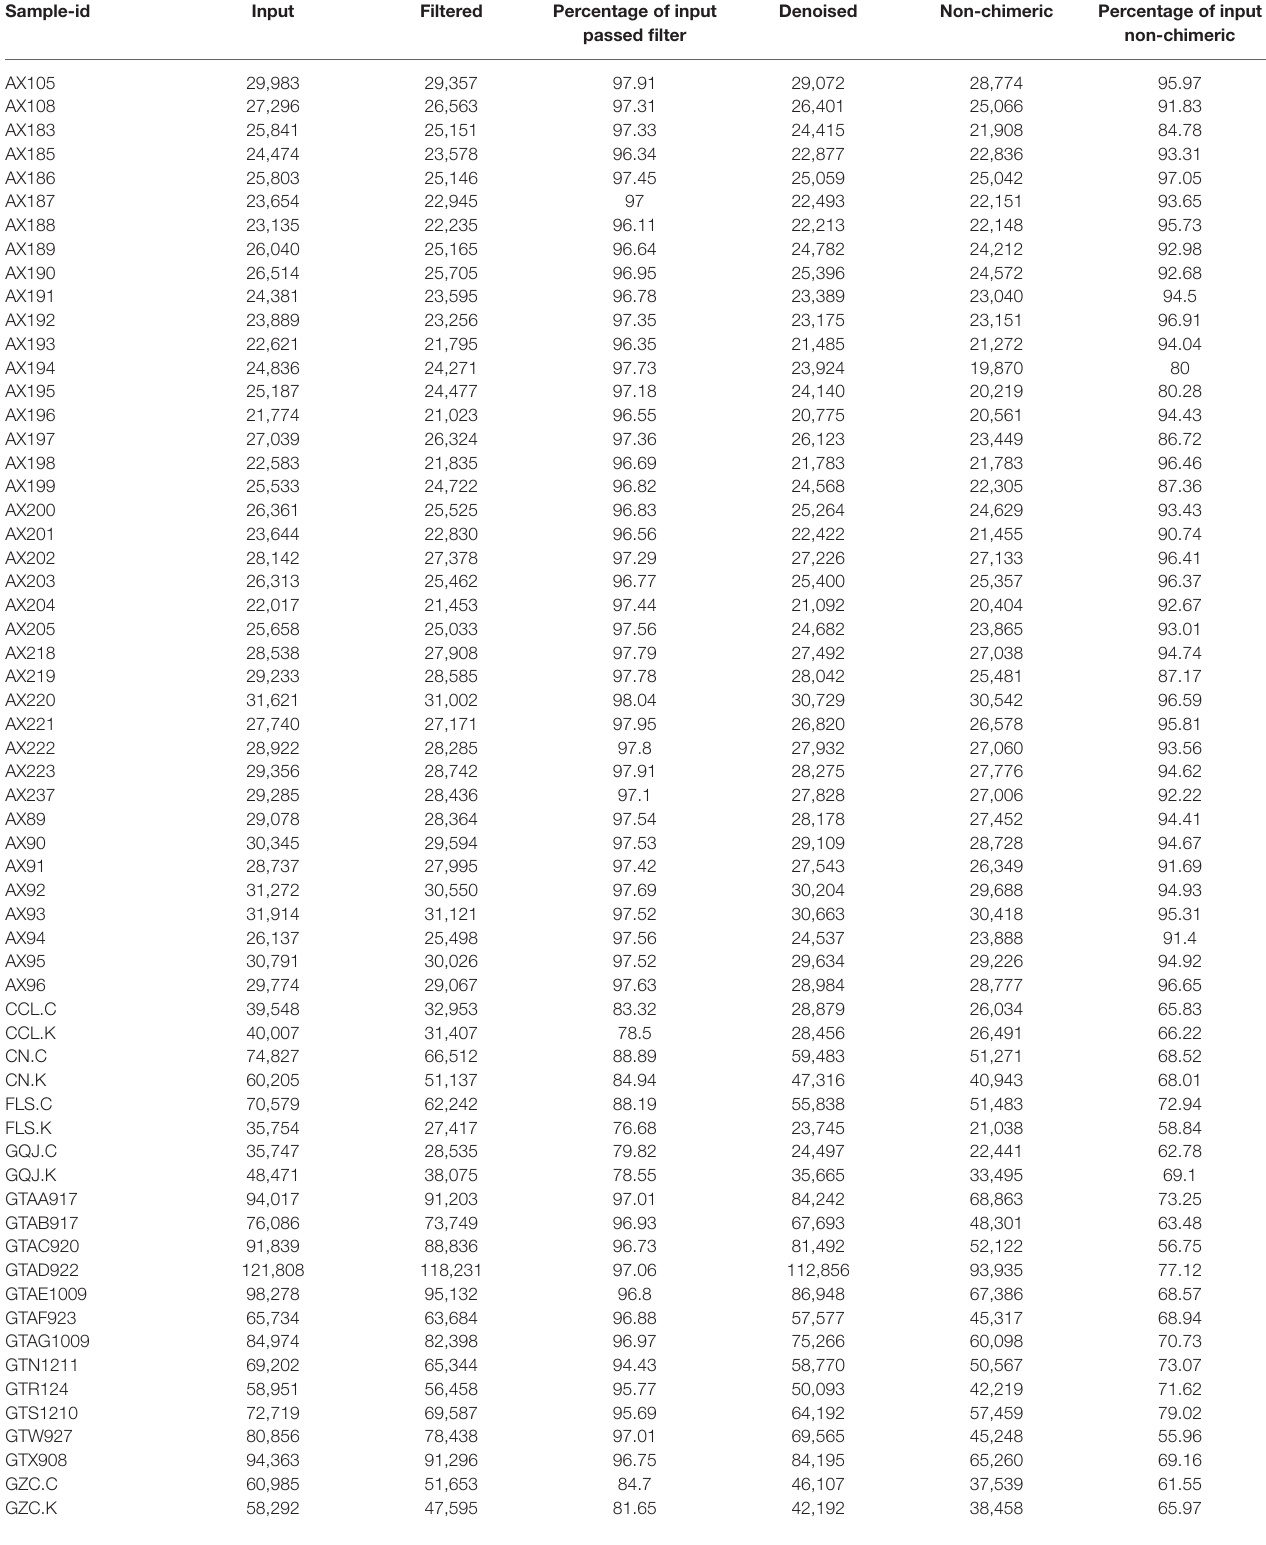
TABLE 3 | Statistics of DADA2